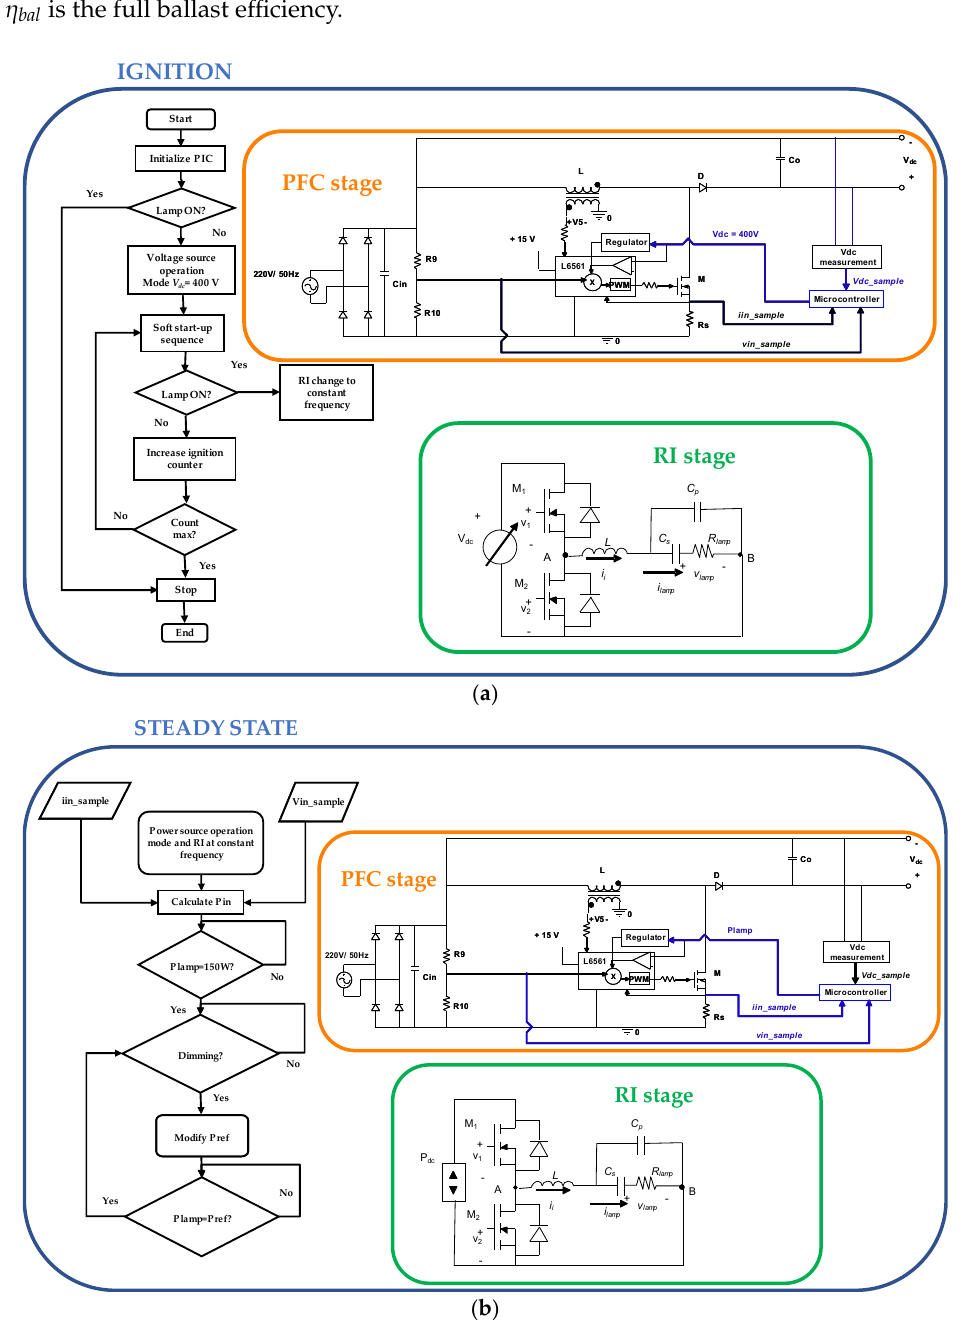
Figure 7. Management of ballast operating modes from the PIC18F2220 microcontroller: ( a ) Ignition and ( b ) during steady state.